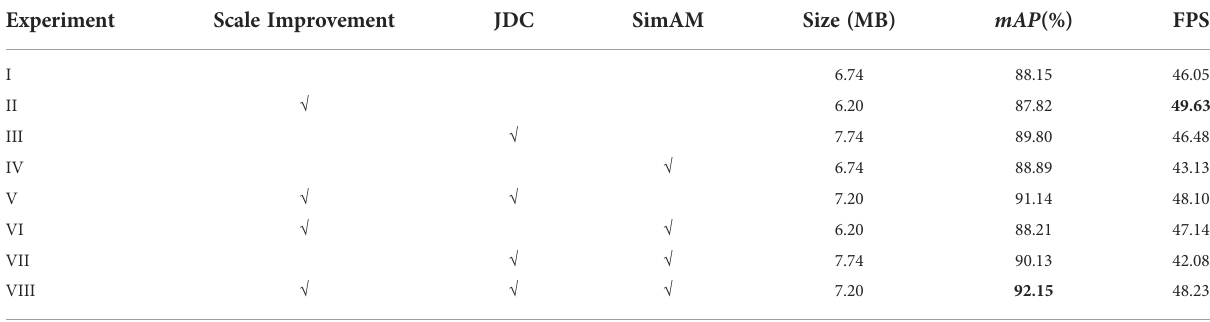
TABLE 4 Results of ablation